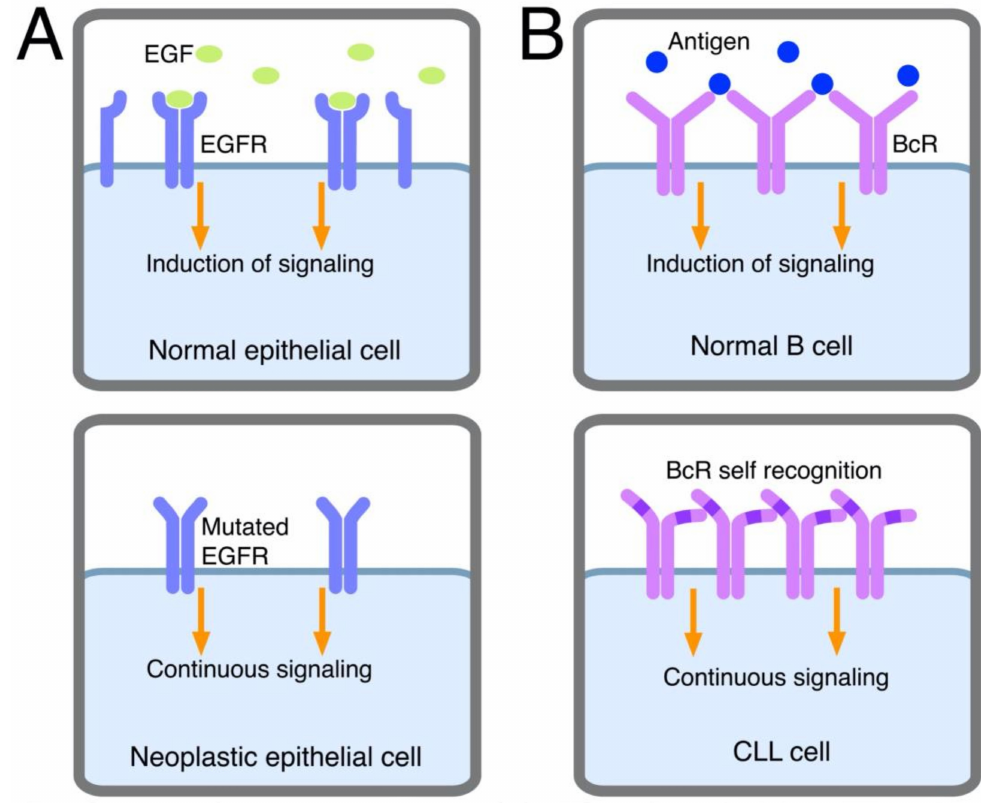
Figure 2. Autonomous signaling in CLL cells. The mechanisms leading to autonomous signaling (( B ), right) are depicted and compared with the continuous signaling delivered by mutated EGFR in cancer epithelial cells (( A ), left). In normal epithelial cells, dimerization of a proportion of the membrane’s EGFR molecules by EGF causes the activation of the downstream pathway, which is transient and lasts until EGF is present in the micro-environment (top). In neoplastic cells, “mutated” EGFR molecules aggregate spontaneously, providing continuous signaling to the cells which are induced to proliferate (bottom). In normal B cells, BcR stimulation is caused by the presence of a specific antigen and is transient (top). In CLL, in which autonomous signaling occurs, BcR signaling is constantly activated since the BcR binds to a specific structure of the BcR itself (marked in blue). Not all the types of BcR engagement occur concomitantly or operate in all CLL